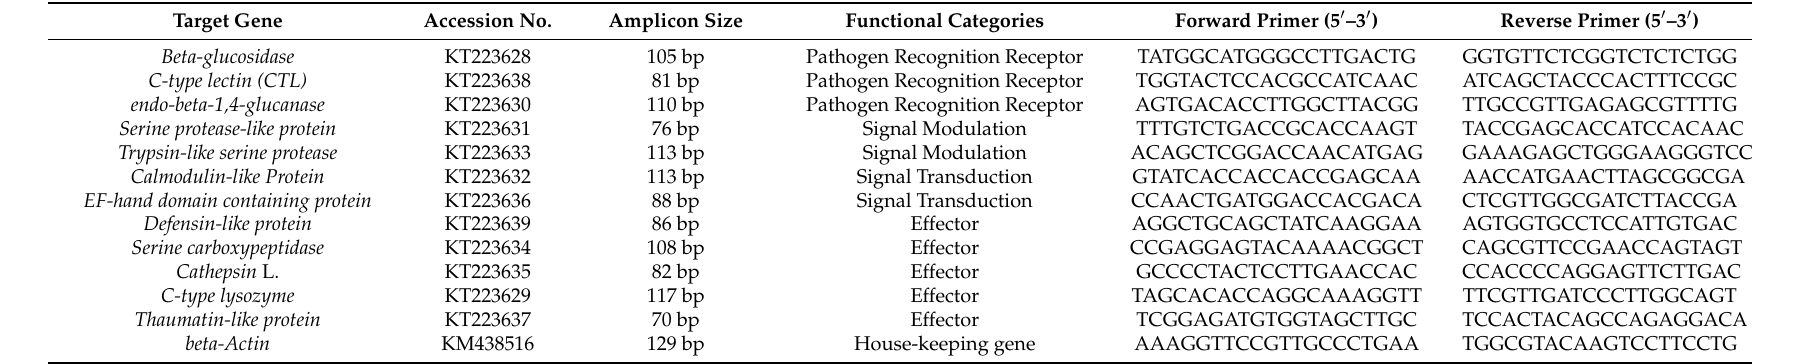
Table 6. Primers used for quantitative real-time